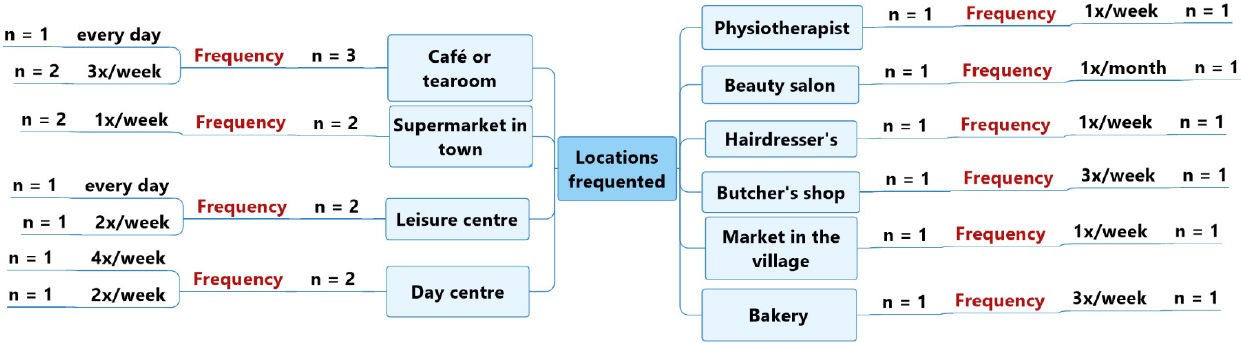
Figure 2. Types of locations frequented by study participants with a probable or diagnosed slight cognitive impairment or mild-to-moderate dementia.